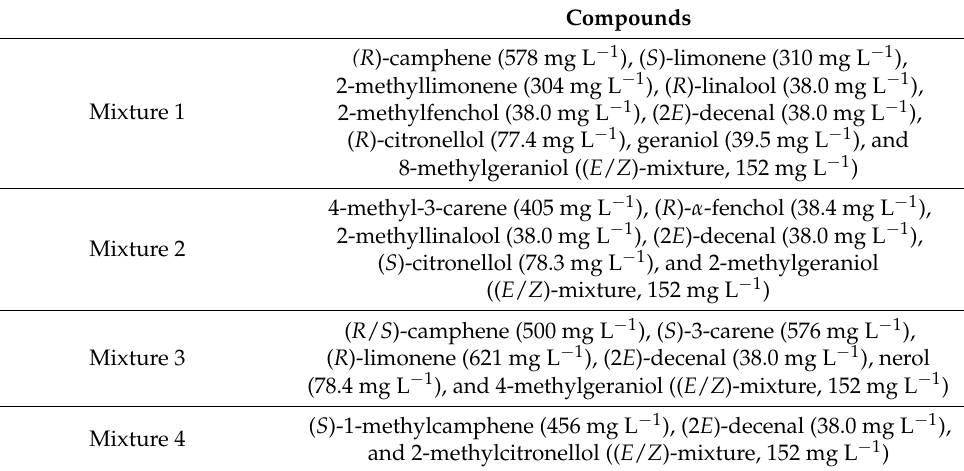
Table 4. Composition of the four mixtures used for the GC-O analysis for determination of the odor thresholds in the